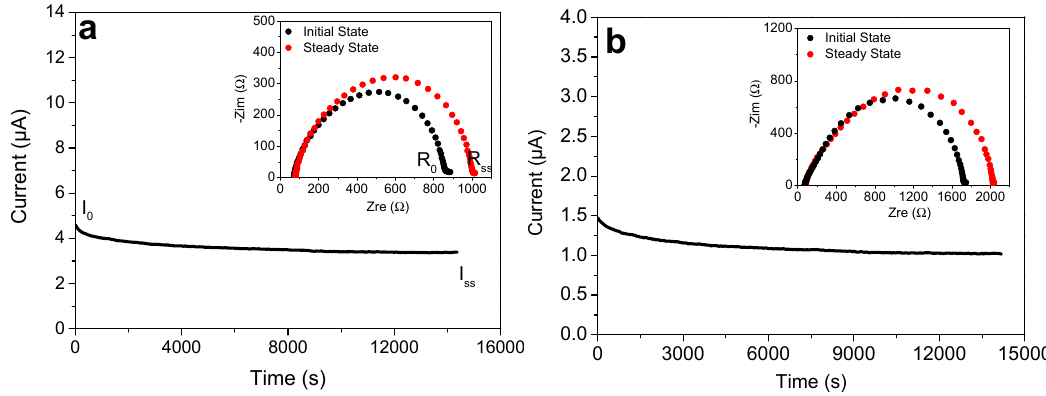
Figure 11. Time-dependence response of DC polarization for ( a ) Li | celgard | triazole gel with LiPF 6 -EC:DEC electrolyte | celgard | Li, and ( b ) Li | celgard | triazolium + / PF6 − gel with LiPF 6 -EC:DEC electrolyte | celgard | Li symmetric cell configuration at an applied DC bias of 5 mV and at 40 ◦ C. The inset shows the impedance spectra of the initial and steady states of the cell with AC bias of 5 m.